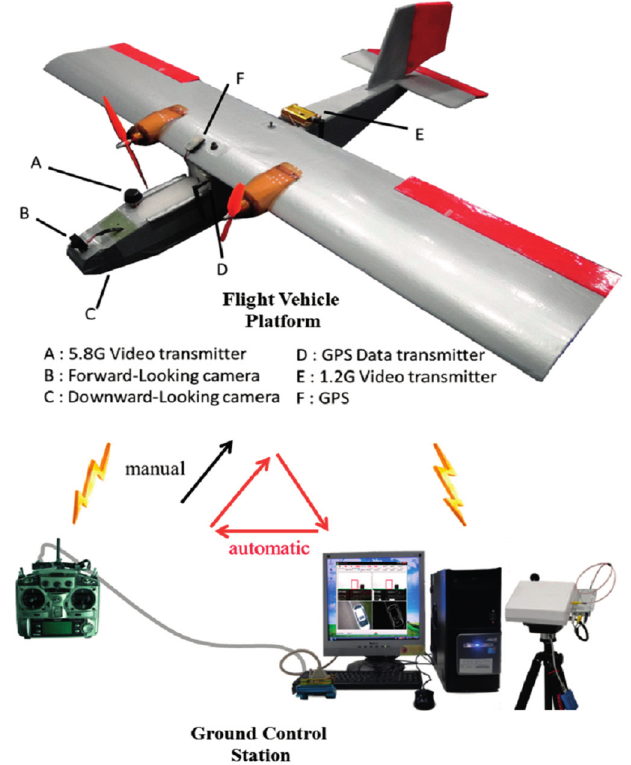
Figure 1. Architecture of the UAV